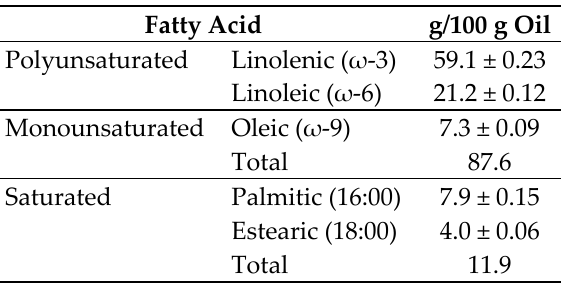
Table 2. Fatty acid profile of chia cultivated in